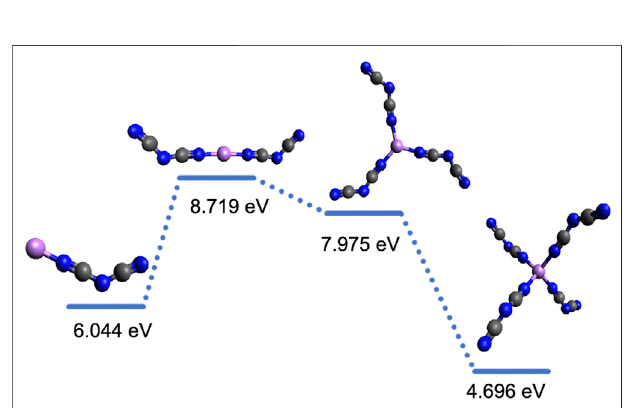
FIGURE 5 | Integral disassociation energies, E D , and representative structures for Li + -[TFSI] solvates with the respective coordination type. The color code for atomsis asfollows: red (oxygen), blue (nitrogen), yellow (sulfur), gray (carbon), purple (lithium), and light blue ( fl uorine).